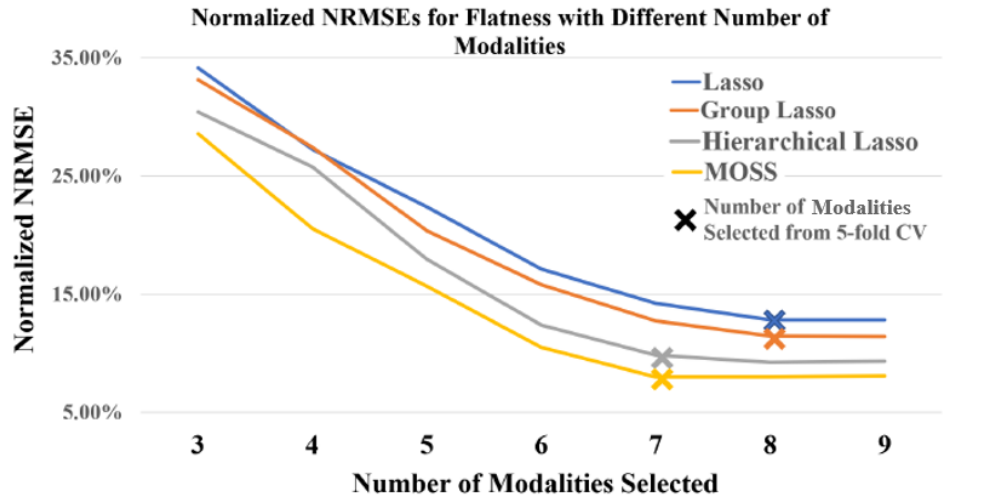
Figure 5. Normalized NRMSEs for Flatness with Different Number of